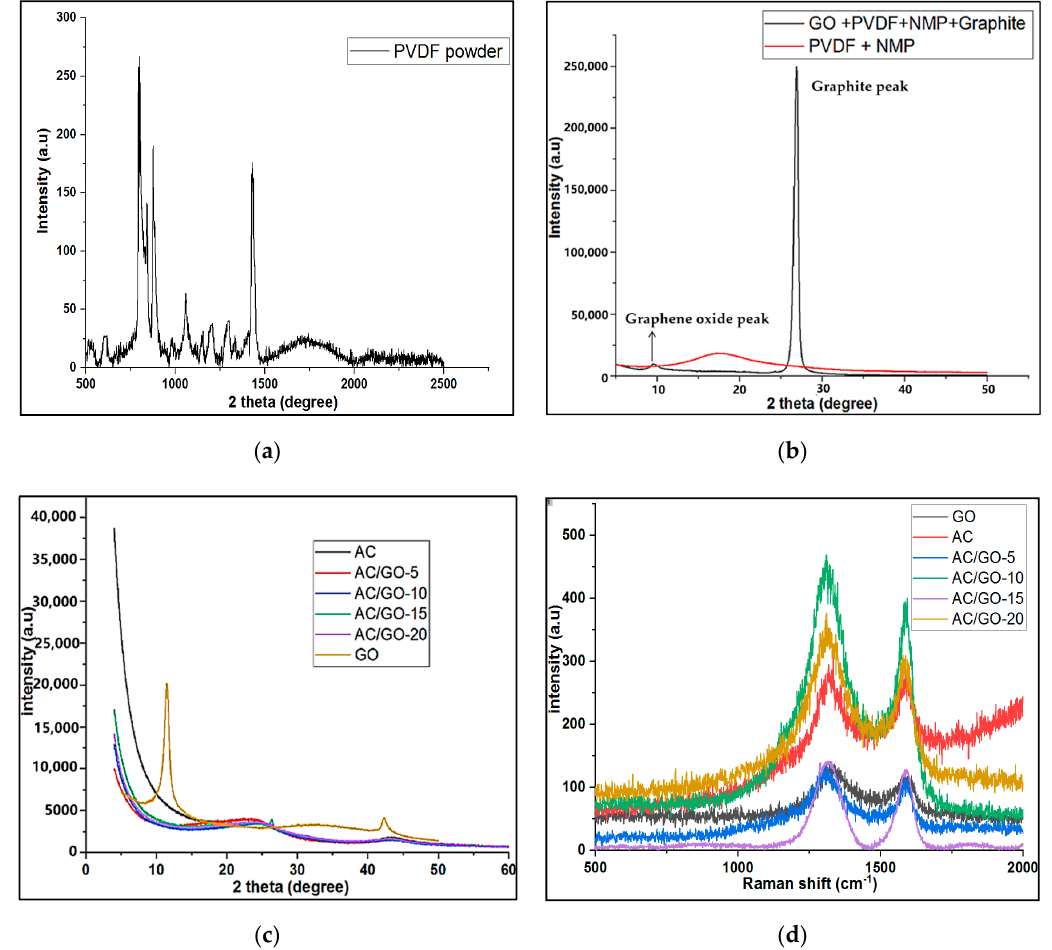
Figure 4. X-ray diffraction (XRD) of ( a ) Pure PVDF powder ( b ) PVDF dispersed in NMP solvent Figure 4. X-ray di ff raction (XRD) of ( a ) Pure PVDF powder ( b ) PVDF dispersed in NMP solvent containing GO and graphite. ( c ) AC, GO and AC/GO-x electrodes. Raman spectroscopy of ( d ) AC, containing GO and graphite. ( c ) AC, GO and AC / GO-x electrodes. Raman spectroscopy of ( d ) AC, GO GO and AC/GO-x electrodes. and AC / GO-x